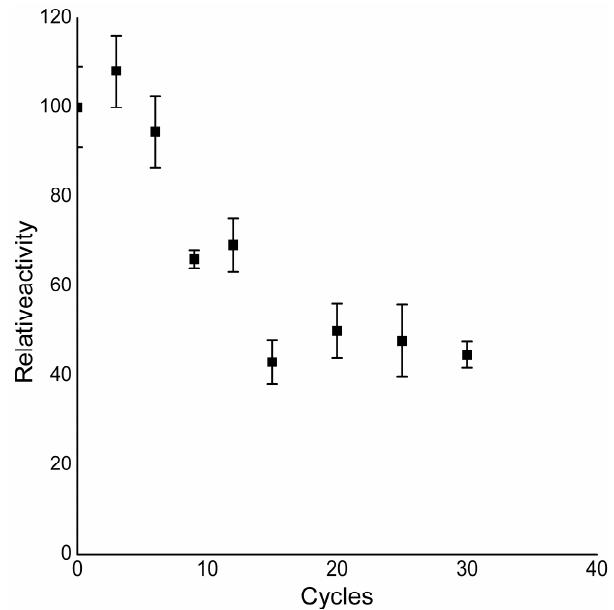
Figure 8. Evaluation of the stability of ALDC immobilized in beer during cycles of exhibition. Error bars represent the standard deviation from the mean of three independent experiments.